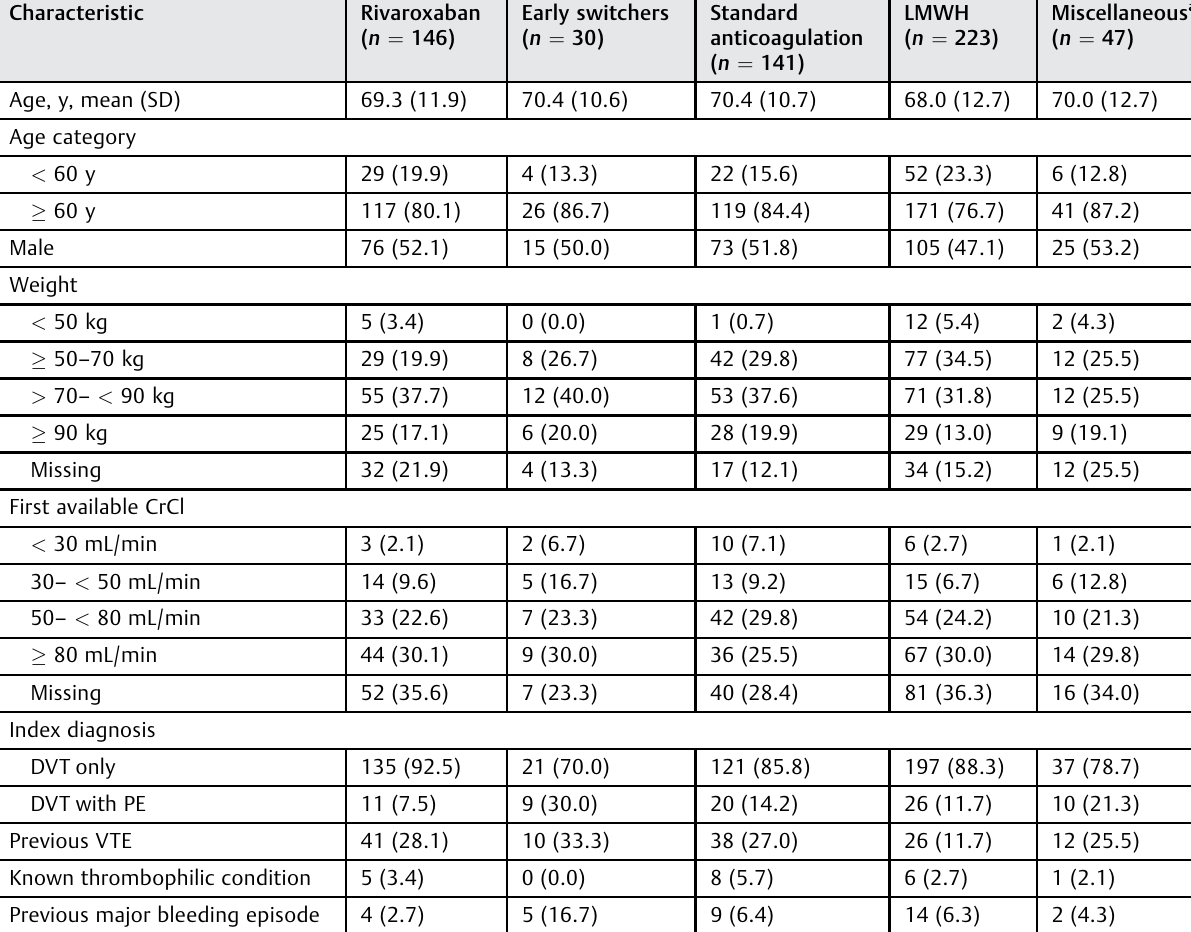
Table 1 Baseline demographics and clinical characteristics of patients with cancer at baseline Characteristic